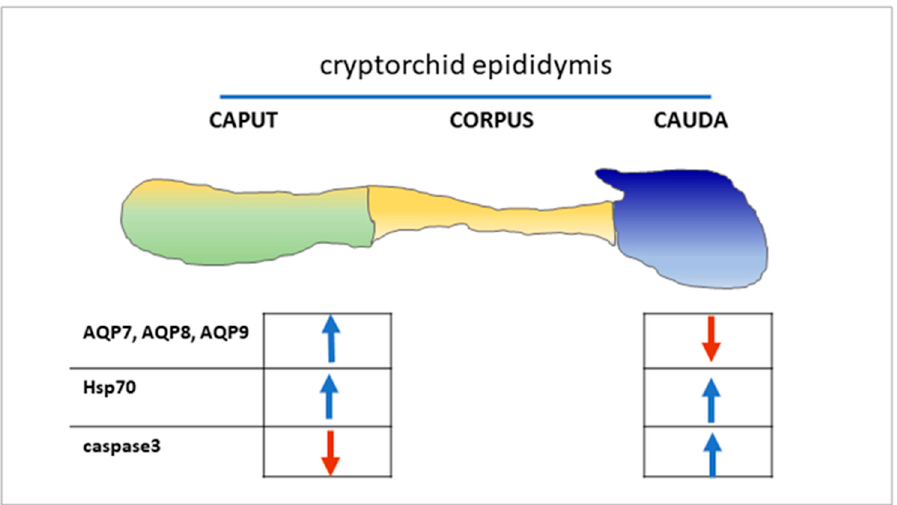
Figure 7. Regulation in the expression levels of AQPs, Hsp70, and caspase-3 in the epididymal tracts of cryptorchid dogs.